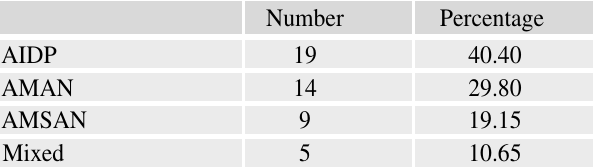
Table III: Electrodiagnostic types of the study